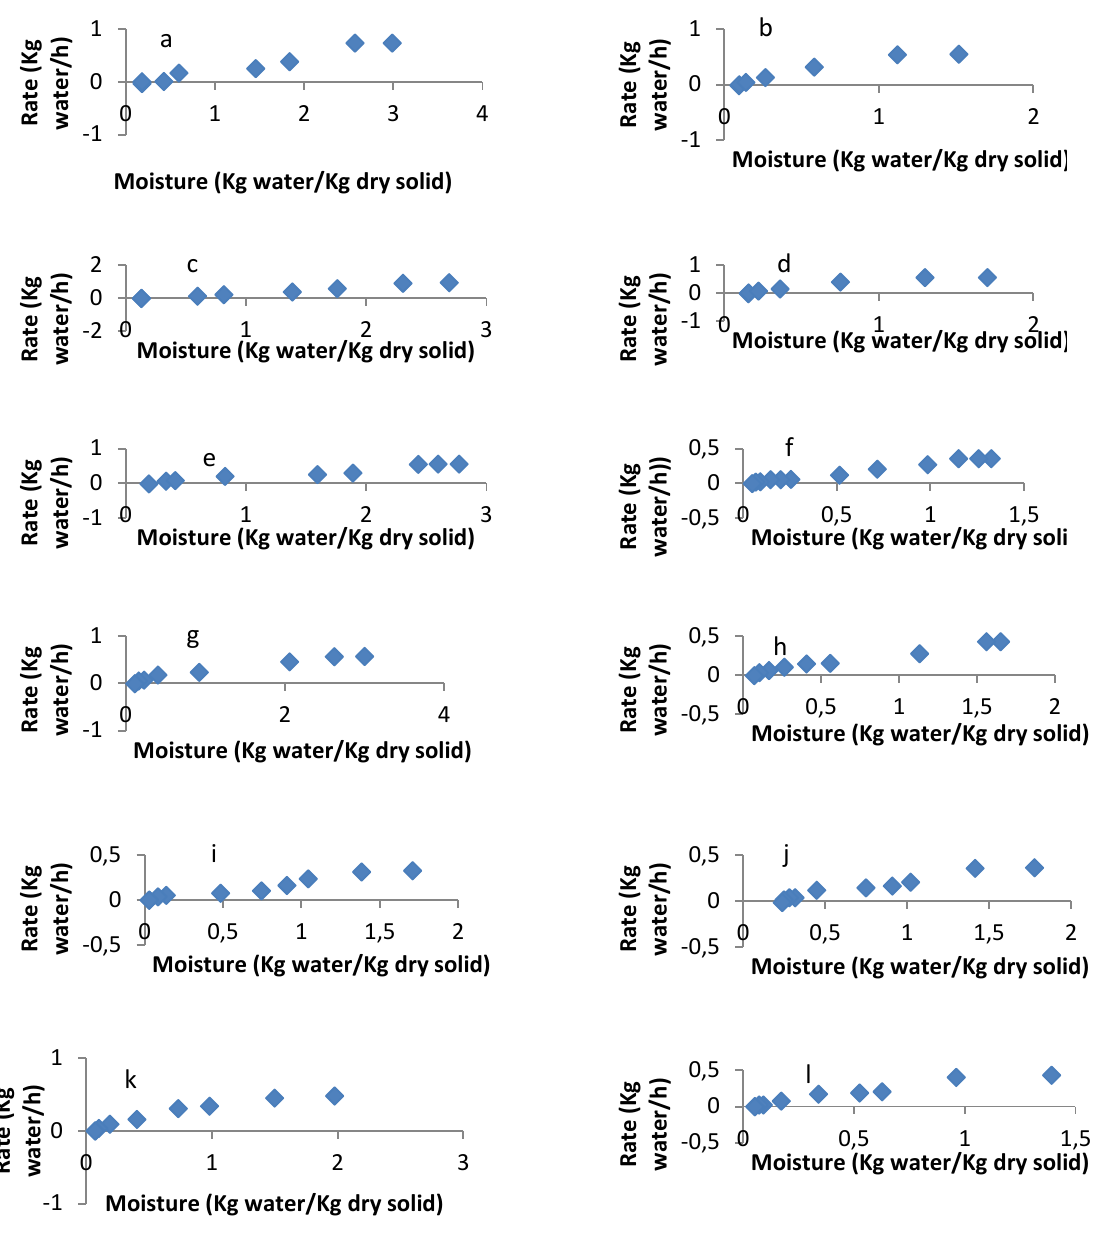
Figure 2: Drying rate curves for: a: Unblanched cardaba banana oven-dried at 70°C; b: Unblanched plantain oven-dried at 70°C; c: Blanched cardaba banana oven-dried at 70°C: d: Blanched plantain oven-dried at 70°C; e: Unblanched cardaba banana oven-dried at 50°C; f: Unblanched plantain oven-dried at 50°C; g: Blanched cardaba banana oven-dried at 50°C; h: Blanched plantain oven-dried at 50°C; i: Unblanched cardaba banana sun-dried; j: Unblanched plantain sun-dried; k: Blanched cardaba banana sun-dried; l: Blanched plantain